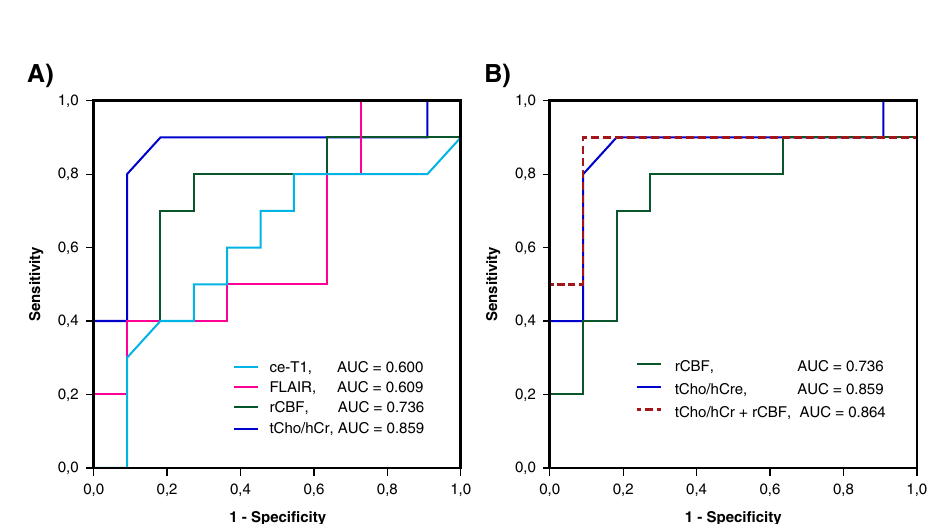
Fig. 3 a Receiver operating characteristic (ROC) curves for tCho/hCr, FLAIR volume, ce-T1 volume and rCBF. b The combined tCho/hCr + rCBF index provides an improvement over tCho/hCr and rCBF alone. Area under curve (AUC) is indicated for each